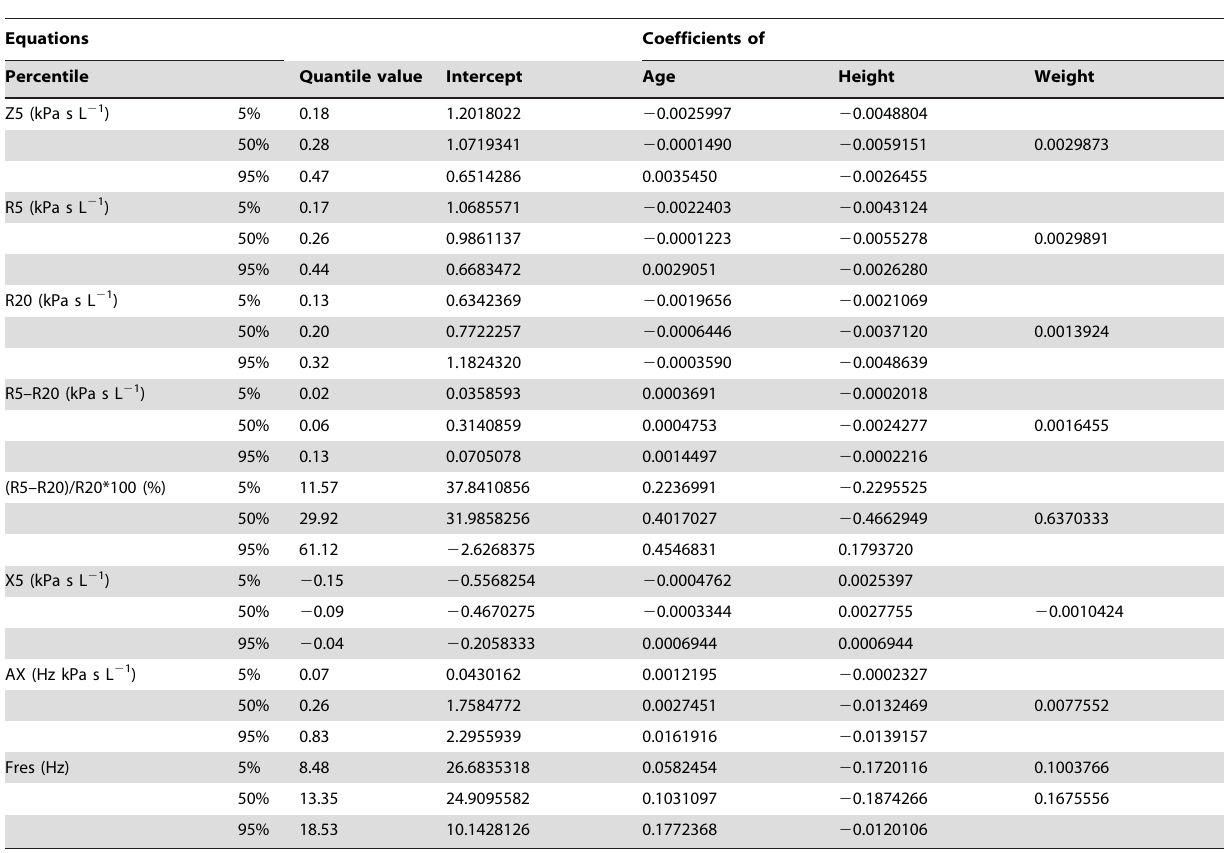
Table 3. Reference equations of commonly applied IOS indices for men.